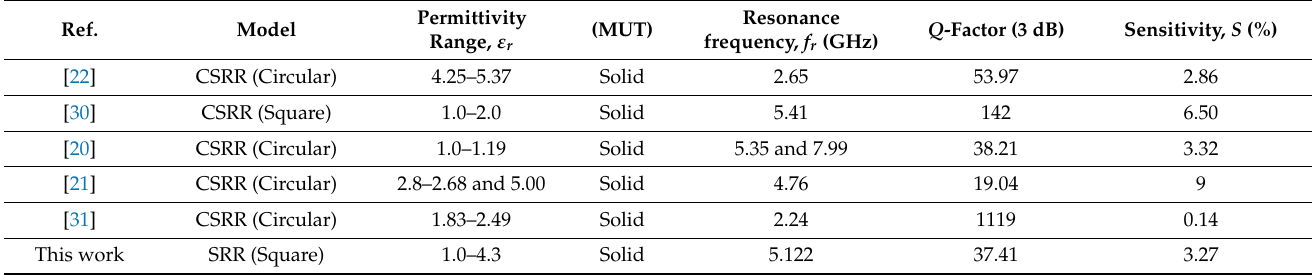
Table 6. State-of-the-art